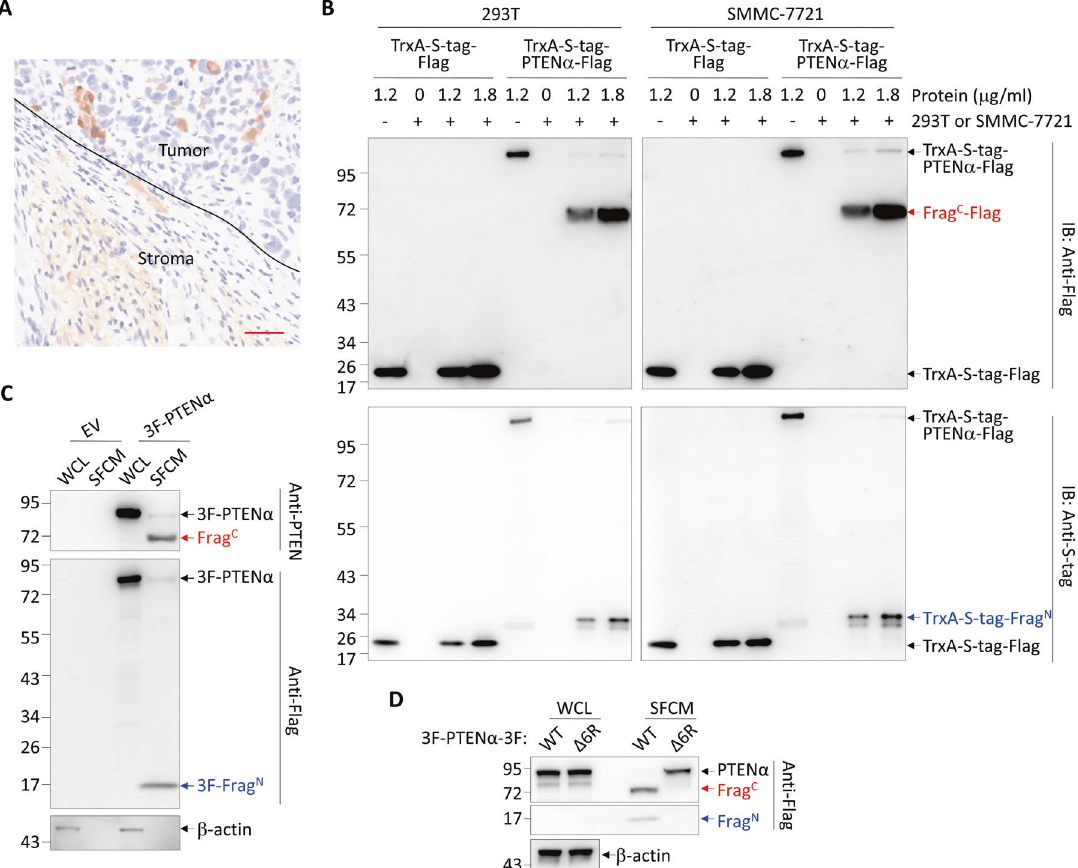
Fig. 2 PTEN α is ef fi ciently cleaved in the extracellular space. A Representative image of the immunohistochemistry staining with an anti- Flag antibody in the section of a xenograft derived from SMMC-7721 Δ PTEN cells expressing PTEN α -3F. Scale bar, 50 μ m. B Bacterially puri fi ed TrxA-S-tag-Flag or TrxA-S-tag-PTEN α -Flag was co-cultured with and without 293 T or SMMC-7721 cells for 4 hours in SFCM. Western blot analysis for the indicated proteins in the SFCM was performed. C , D Western blot analysis for the indicated proteins in the WCL and SFCM of 293 T cells transfected with EV or 3F-PTEN α ( C ) and PTEN α -WT or PTEN αΔ 6 R tagged by 3×Flag at both ends ( D ). 3 F 3×Flag, WCL whole-cell lysate, SFCM serum-free conditioned